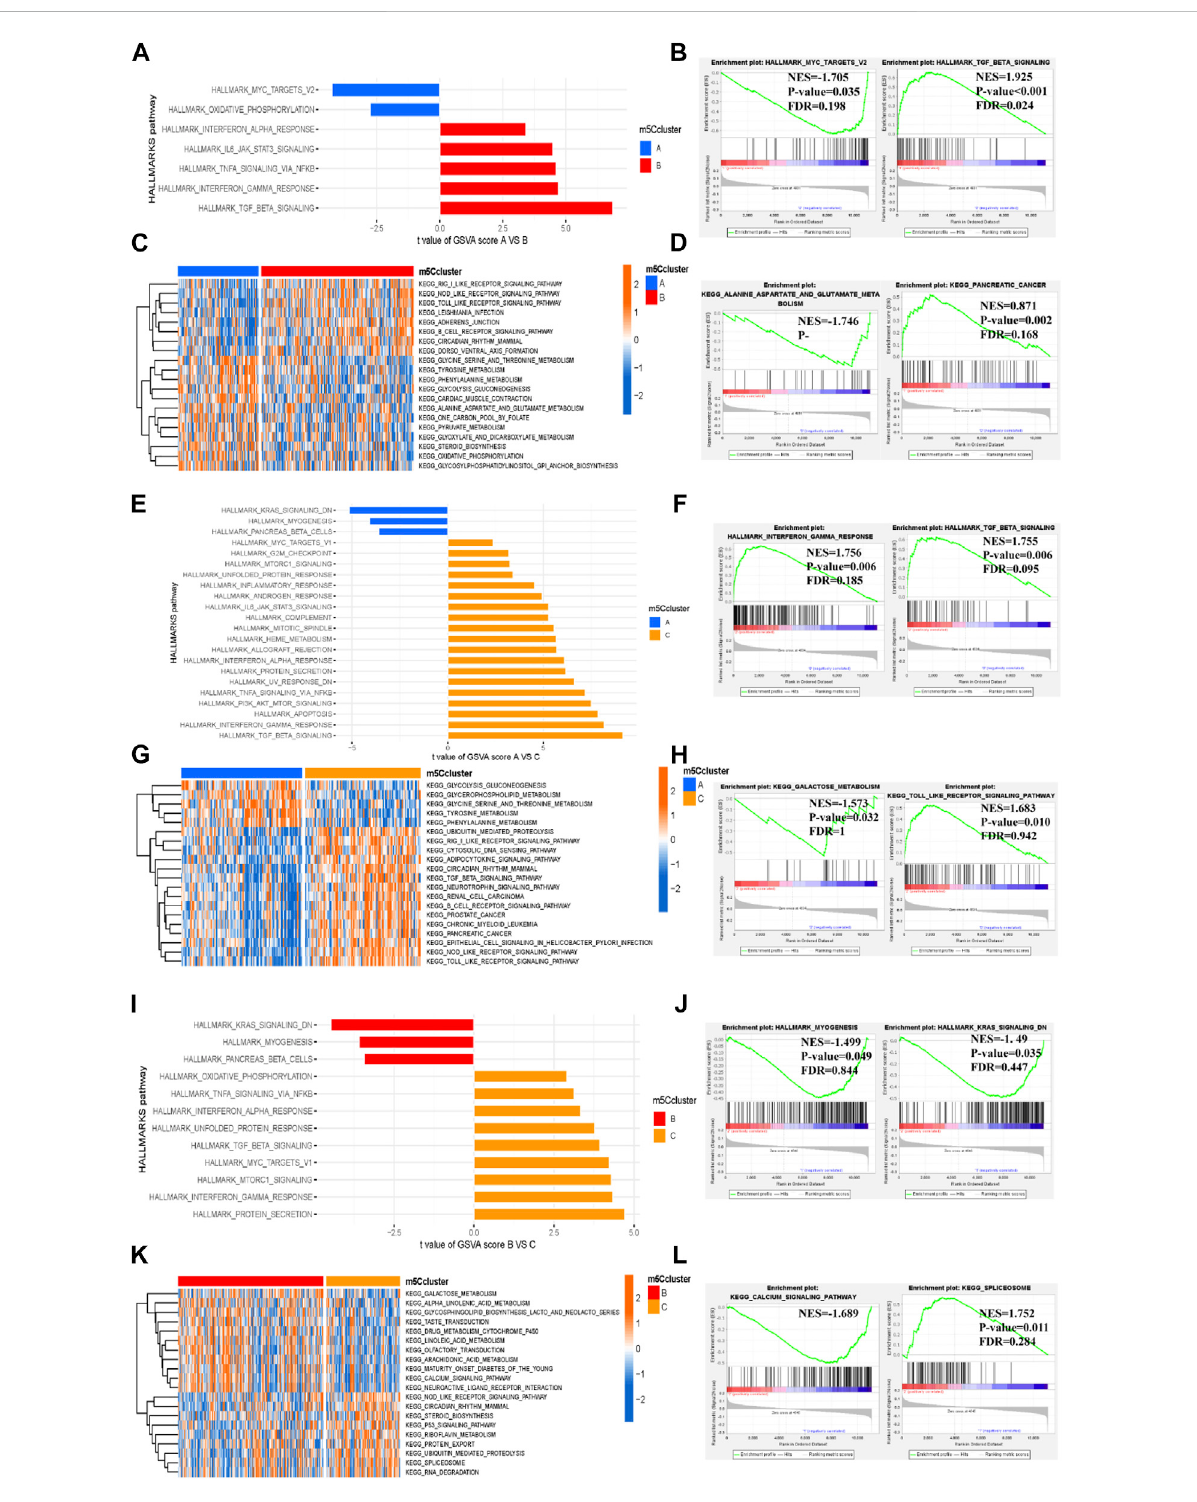
FIGURE 6 Biological functional characteristics of the three distinct m 5 C clusters. (A – D) HALLMARK pathway and KEGG pathway between m 5 C clusters A andB( (A,B) forHALLMARKpathwayand (C,D) forKEGGpathway). (E – H) HALLMARKpathwayandKEGGpathwaybetweenm 5 Cmodi fi cationclusters A and C ( (E,F) for HALLMARKS pathway and (G,H) for KEGG pathway). (I – L) HALLMARK pathway and KEGG pathway between m 5 C modi fi cation clusters B and C ( (I,J) for HALLMARKS pathway and (K,L) for KEGG